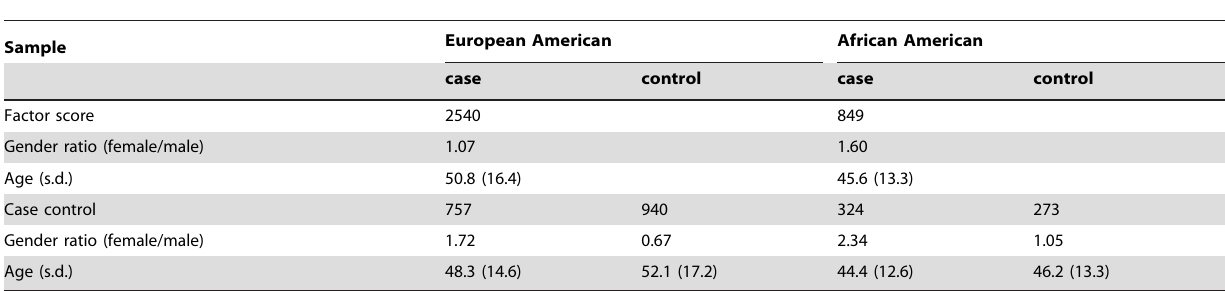
Table 1. Demographic characteristics of European and African American